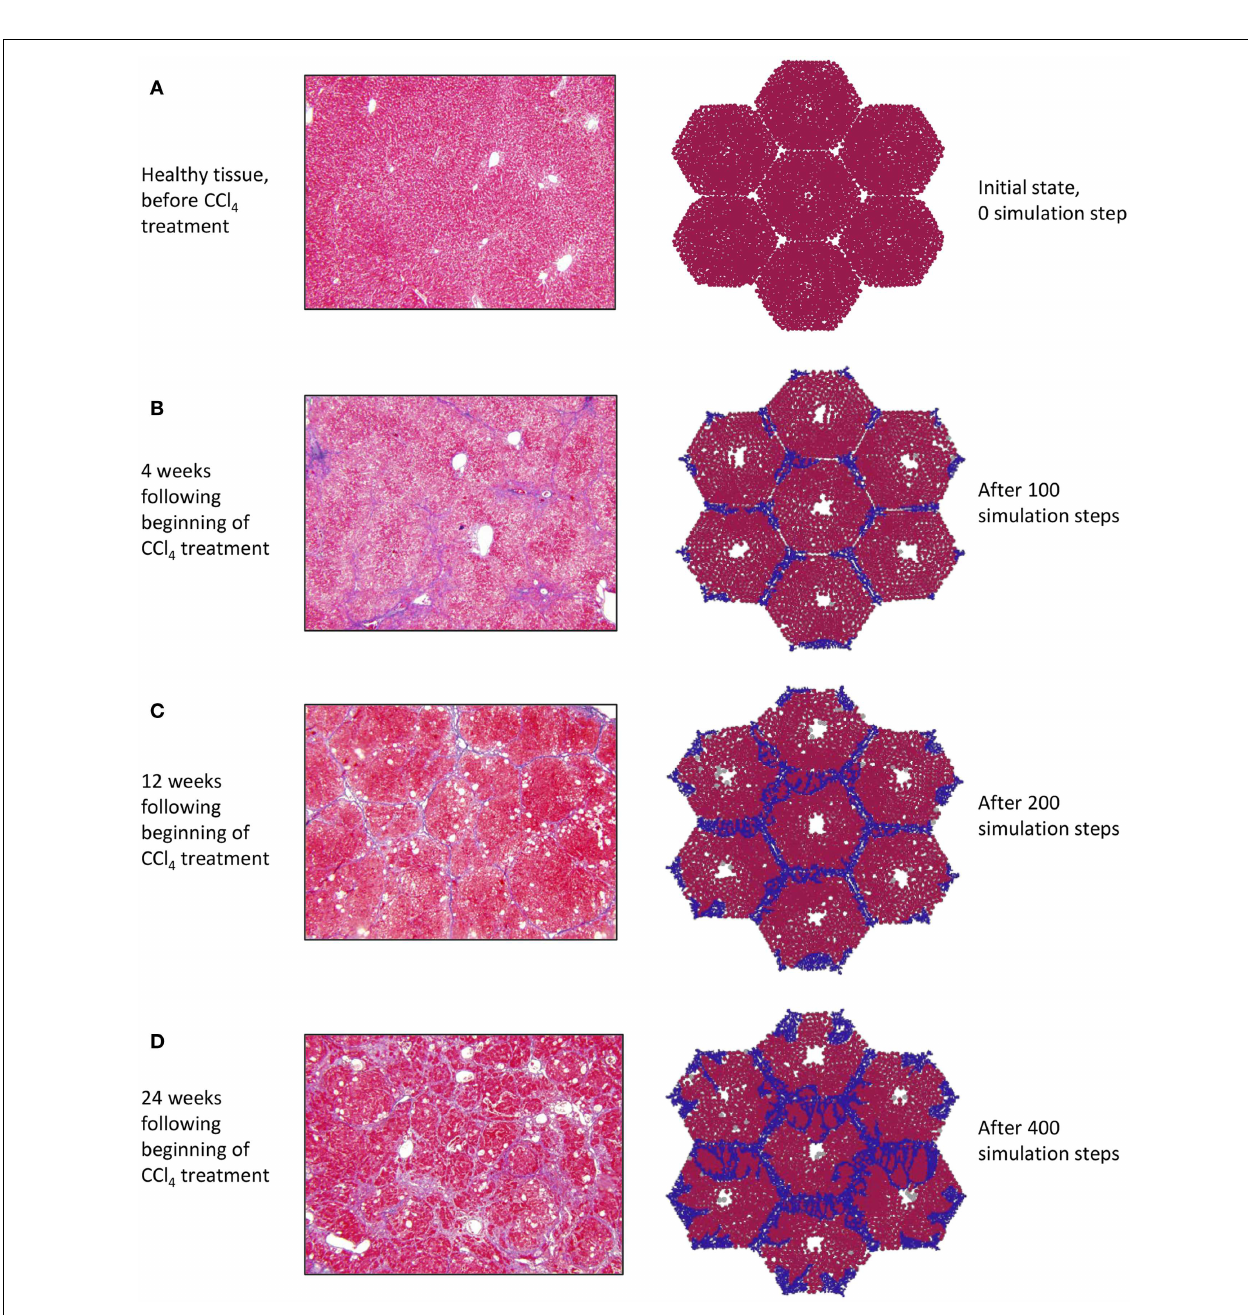
FIGURE 3 | (A–D) Progression of fibrosis in experimentally obtained sections (left column) vs. in ABM simulation (right column); collagen appears blue in Masson’s trichrome stain (left), collagen agents in the model are also blue